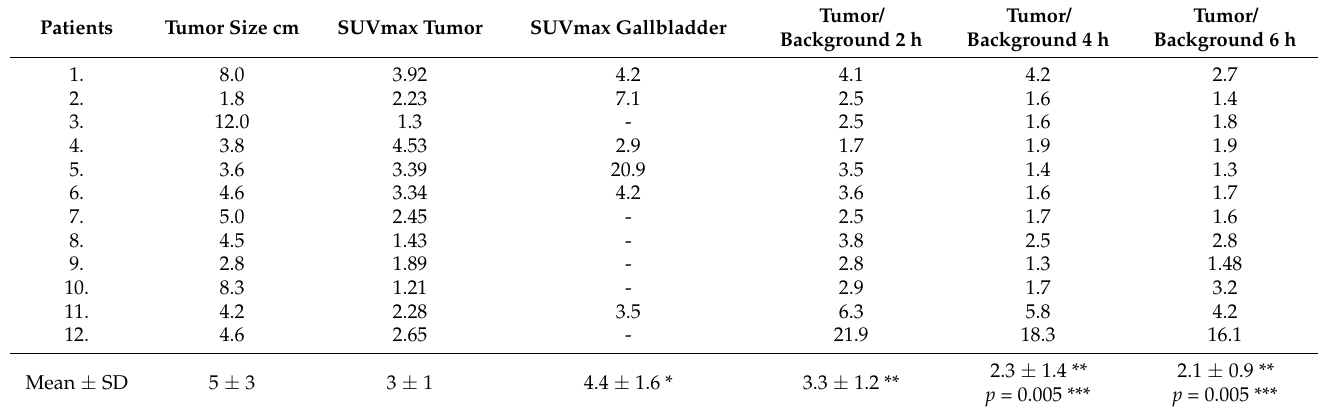
Figure 7. ( A ) SPECT/CT images of patient 11 at 2 h after injection of [ 99m Tc]Tc-TG. Elevated [ 99m Tc]Tc- TG uptake in the humerus head (SUVmax = 2.28) is visualized (arrows). No pathological changes were found using CT. The upper setting of the scale window (22% of the maximum number) was adjusted to visualize the lesion. ( B ) MRI image of the left shoulder joint, T1. Table 4. Tumor size, SUVmax (at 2 h) and tumor-to-contralateral site ratios (at 2, 4 and 6 h) after the injections of [ 99m Tc]Tc-TG.